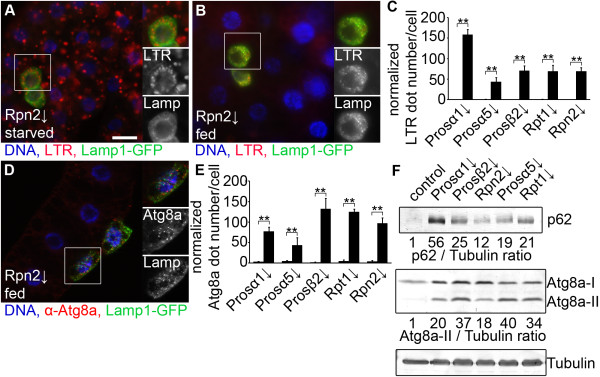
Proteasome impairment enhances autophagy in Drosophila larvae. A) Depletion of Rpn2 increases punctate Lysotracker Red (LTR) staining in Lamp1-GFP marked larval fat body cell clones of starved animals relative to surrounding control cells. B)Rpn2 knockdown induces autophagy in fat body cell clones of well fed larvae, as LTR dots are only observed in GFP-positive RNAi cells but not in control cells. C) Silencing of genes encoding different proteasome subunits results in a statistically significant induction of punctate LTR in well fed conditions (u test, n = 5-7 per genotype, ** P < 0.01), and error bars denote standard error. D) Immunostaining reveals cell-autonomous activation of punctate endogenous Atg8a labeling in Rpn2 RNAi cells, representing autophagosomes. E) Statistical evaluation of the effect of proteasome subunit RNAi on punctate endogenous Atg8a. Statistically significant differences are marked (u or t test, n = 5 per genotype, ** P < 0.01), and error bars denote standard error. (F) Western blots show that RNAi knockdown of genes encoding different proteasome subunits greatly increases the levels of both the specific autophagy cargo p62 and autophagosome-associated lipidated Atg8a-II. Numbers refer to relative expression levels compared to Tubulin, as determined by densitometric evaluation. Boxed areas in A, B and D are shown enlarged. Scale bar in A equals 20 μm for A, B, D.